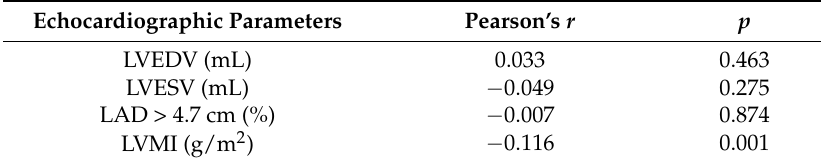
Table 2. Correlation between GNRI and echocardiographic parameters in study